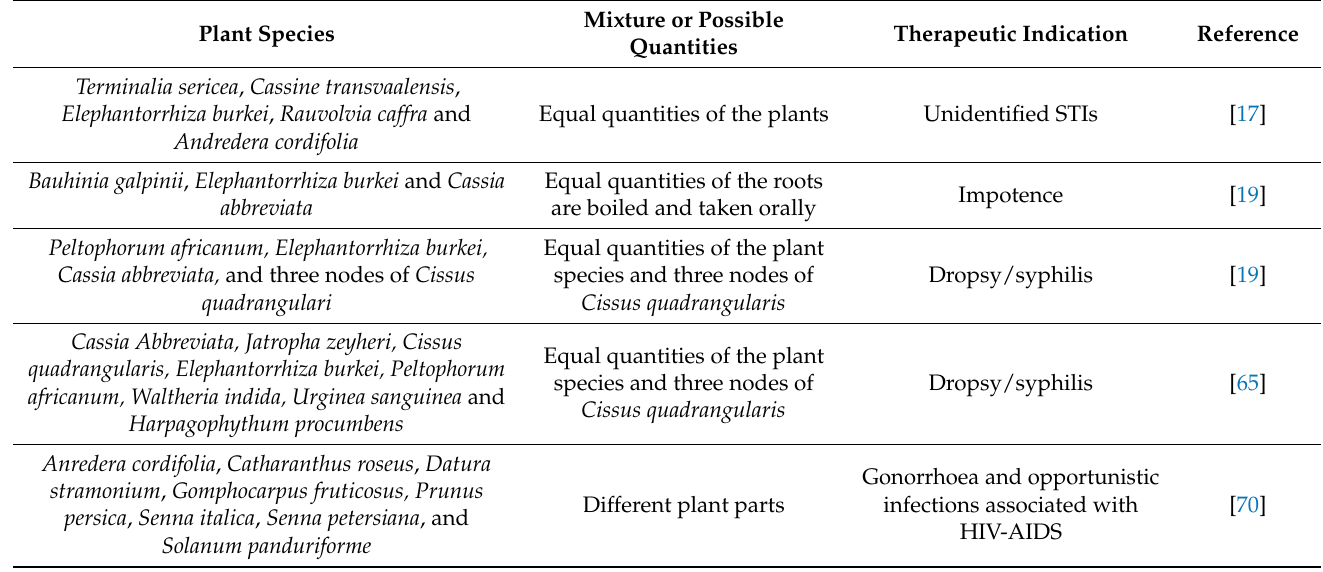
Table 3. Possible mixtures used in the treatment of sexually transmitted and related